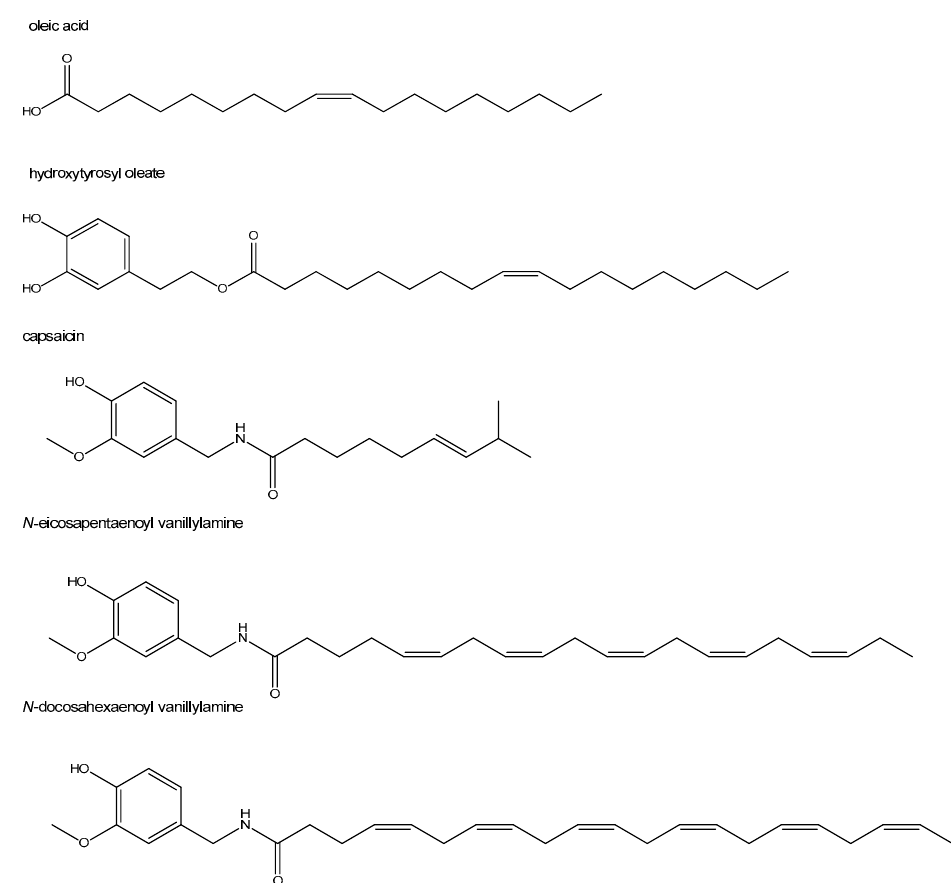
Figure 3. Chemical structures of oleic acid and its conjugate with hydroxytyrosyl, hydroxytyrosol oleate, and of capsaicin and its conjugated forms with EPA and DHA, N -eicosapentaenoyl vanillylamine (EPVA) and N -docosahexaenoyl vanillylamine (DHVA), respectively.